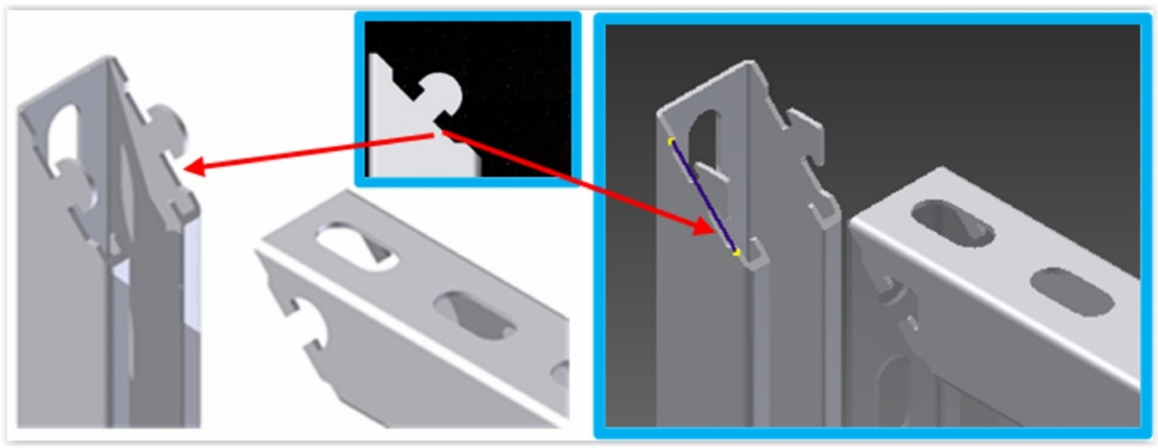
Figure 15. The 3D models of the consoles with a modified contact line (with a dash/shelf) for two lock cases: semirounded and